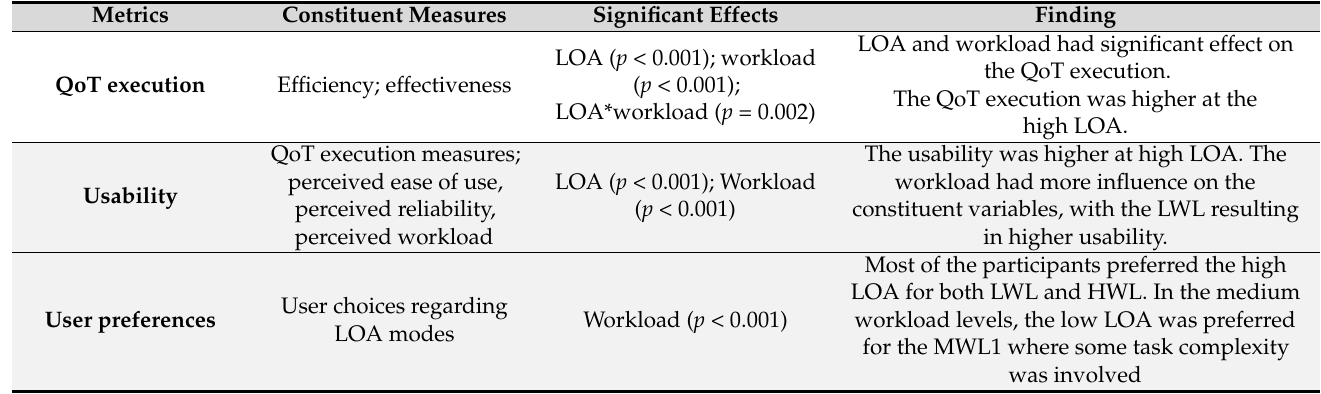
Table 3. Summary of